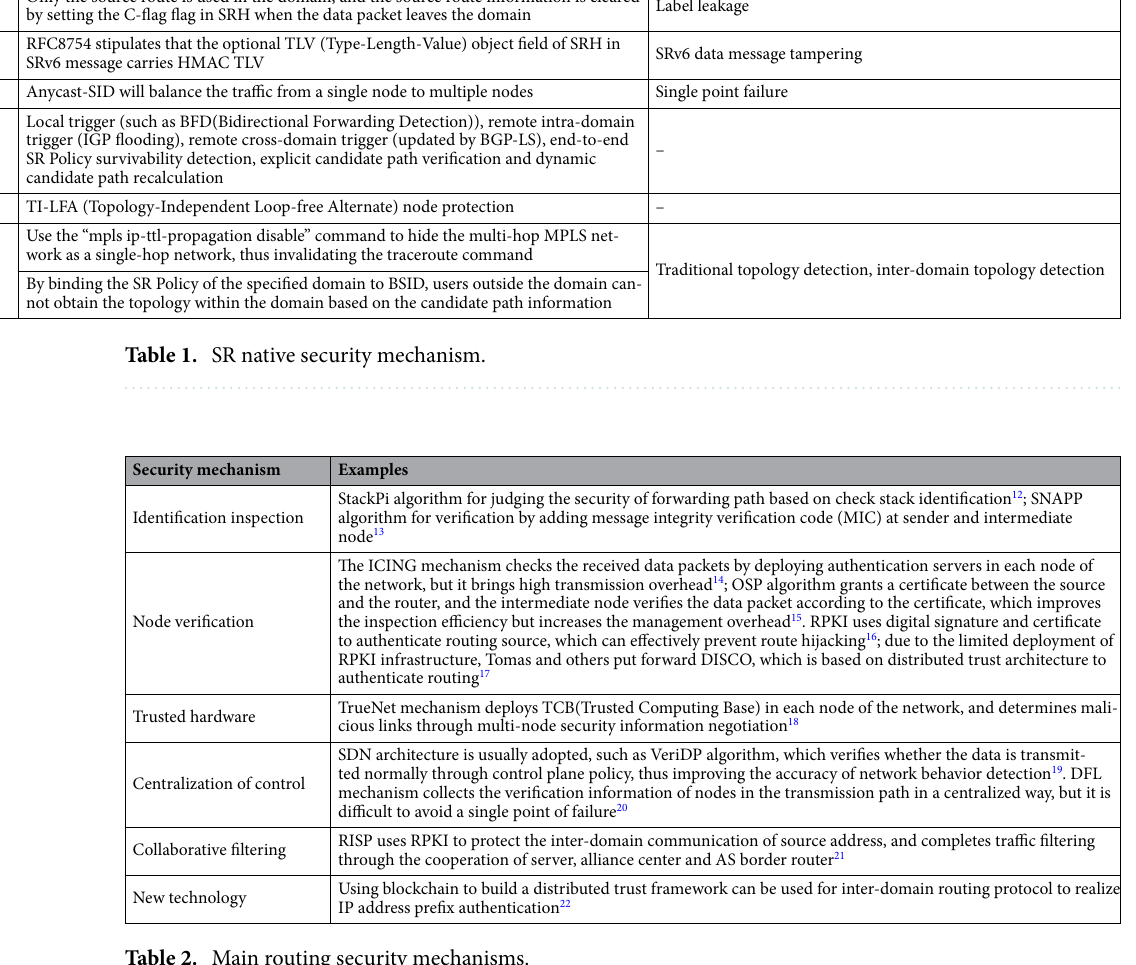
Table 2. Main routing security mechanisms.